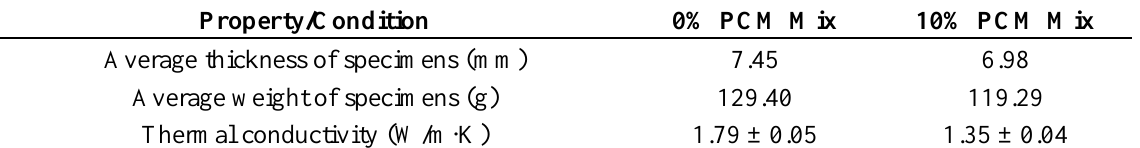
Table 7. Characterization of specimens and test